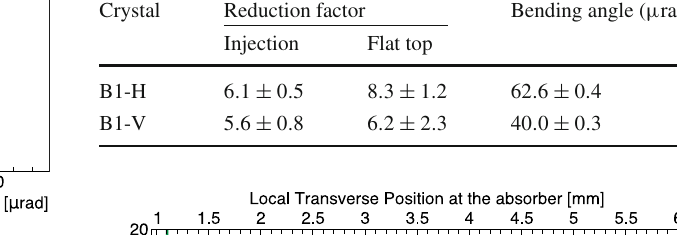
Fig. 5 Local beam losses normalized to the beam flux, and to the BLM signal in amorphous-like orientations, as a function of the crystal angle for the horizontal crystal. The scan was performed at 6.5Z TeV with the horizontal crystal on Beam 1